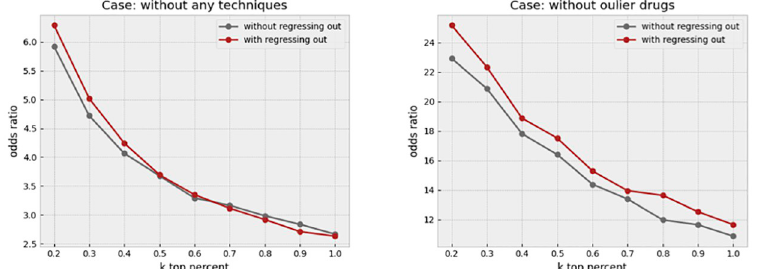
Fig 13. Effect of regressing out the cell area. The left plot shows the increase in the odds ratio by regressing out the cell area from all other features in different k percentages when no other data cleaning method is applied. The right plot shows that regressing out improves the result when just outlier drugs, which exhibit weak phenotypes, were removed.